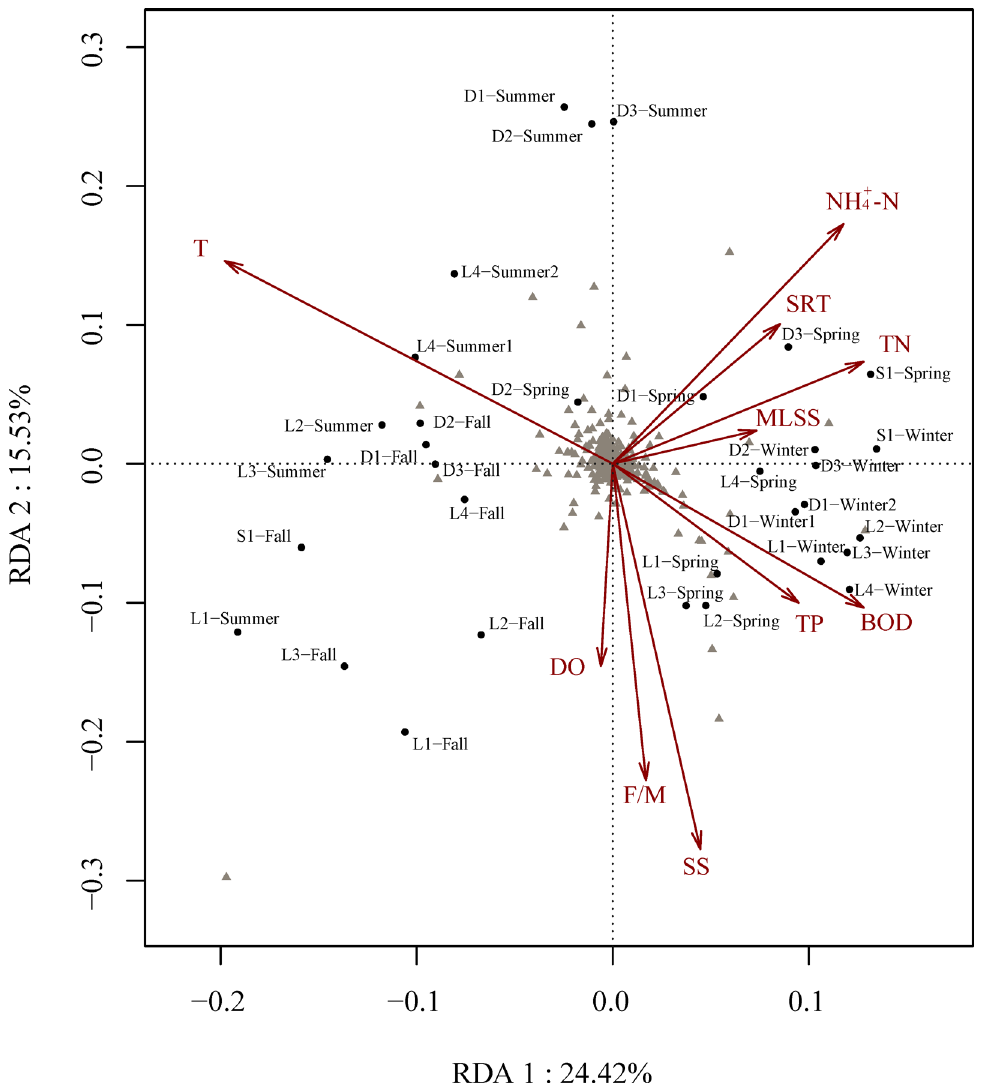
Fig 4. Redundancy analysis (RDA) of OTUs data and measurable variables in all samples. The arrows represent environmental parameters. The length of the arrows indicates the strength of the correlations and the angle of the arrows indicates the direction of variable increment. The triangles represent the species. The dots represent the